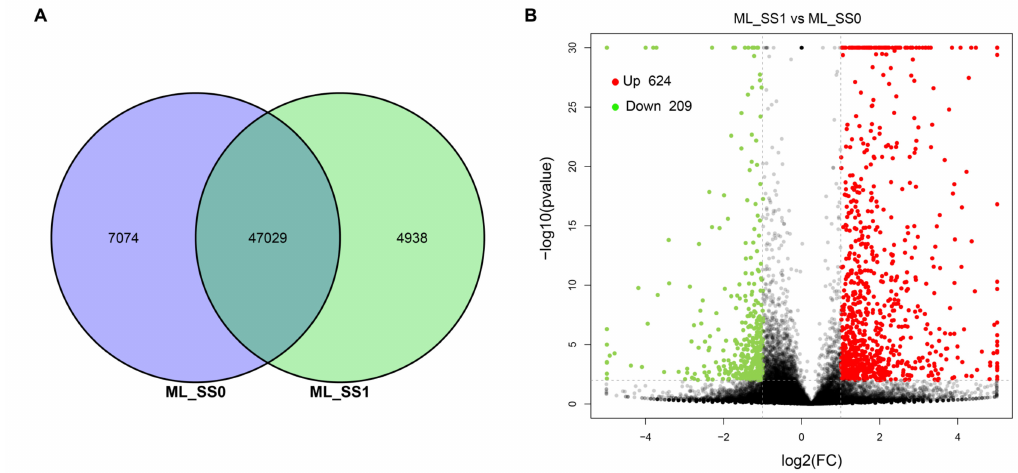
Figure 2. Screening of di ff erentially expressed genes (DEGs). ( A ) Venn chart of co-expressed genes between the samples. ( B ) Numbers of up- and down-regulated DEGs in the infected leaves of M. laevigata .